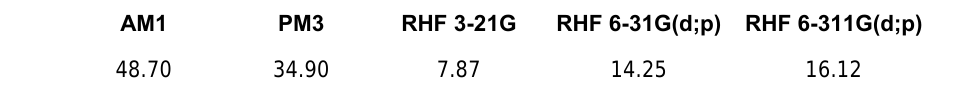
Normal Energy of Formation in